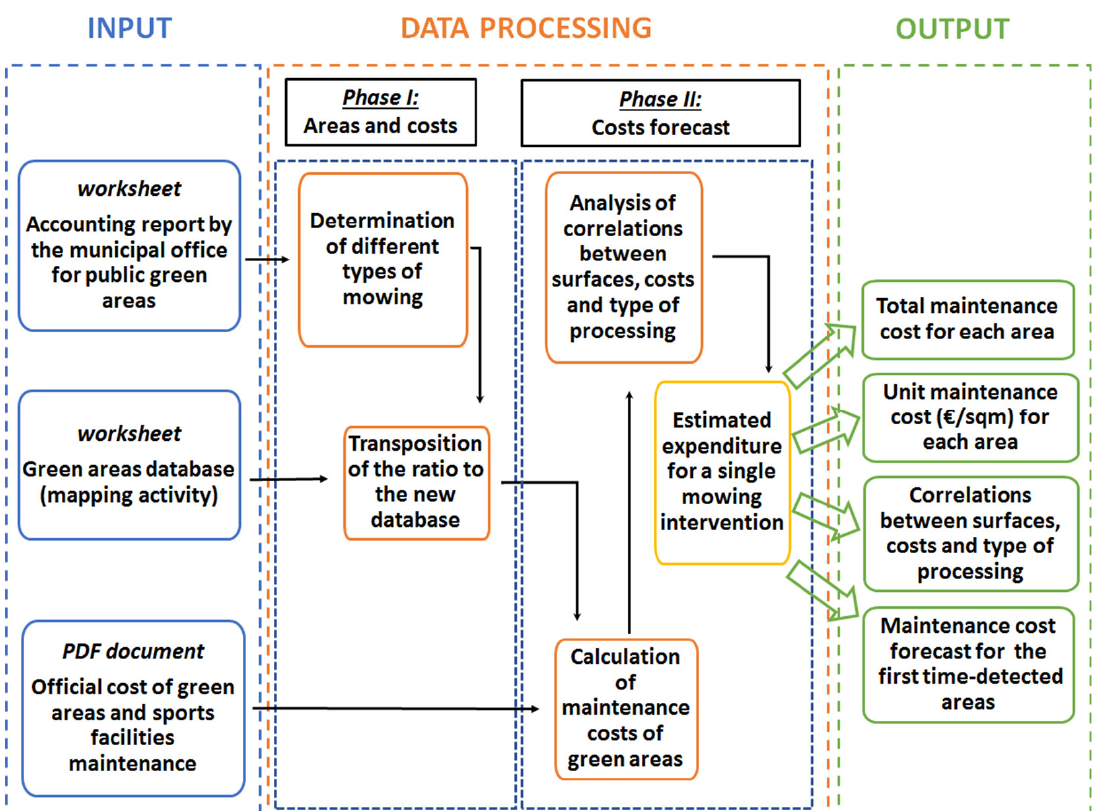
Figure 4. Flowsheet of operations for the evaluation of maintenance costs of green areas managed by the Municipality of Latina.